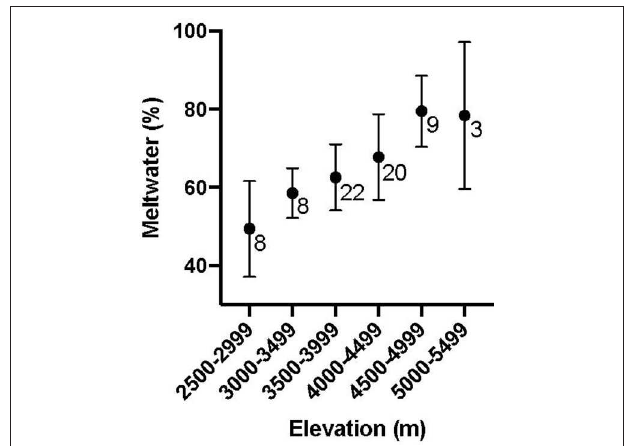
FIGURE 3 | Comparison of the relationship between percent of meltwater contribution and elevation; for each elevation group, circle represents mean, bars represent one standard deviation, and number represents number of